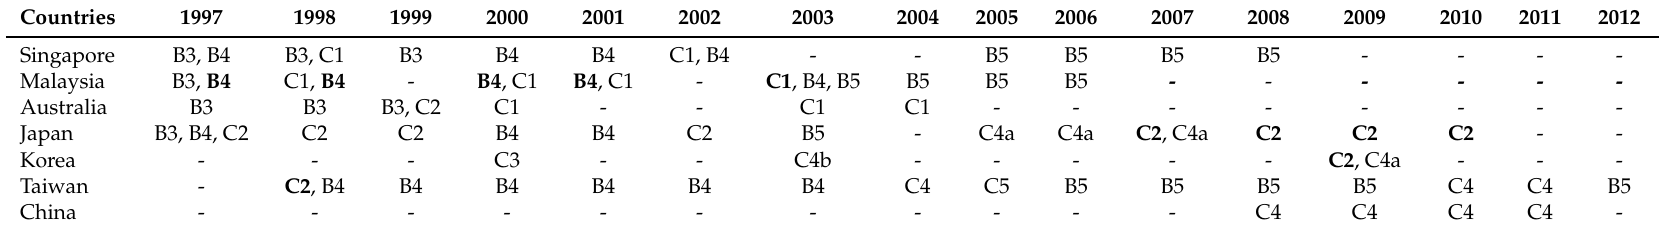
Bold type indicates predominant; -, no data